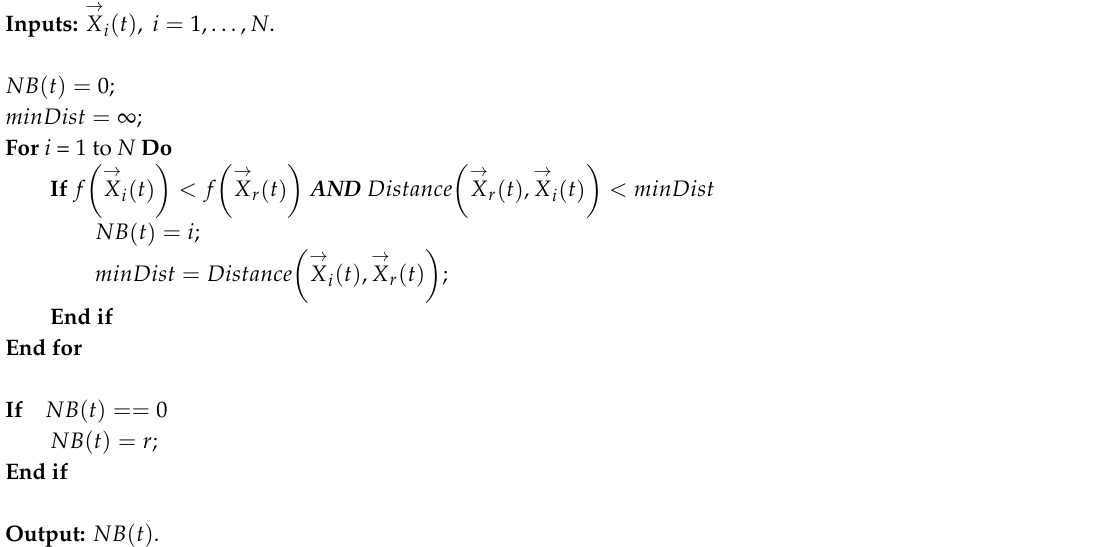
Algorithm 2: Outline of finding the nearest-better neighbor for particle r